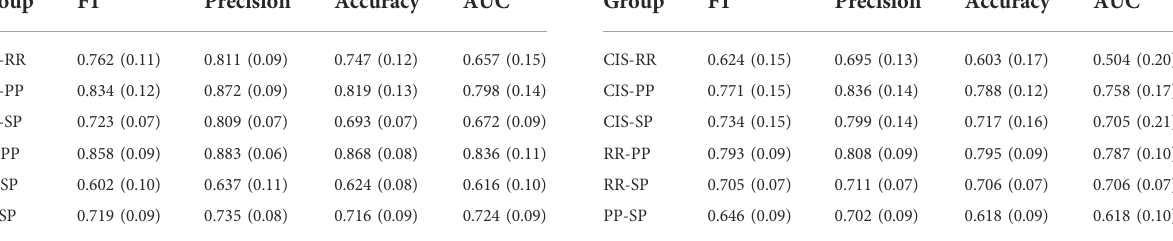
TABLE4Mean(st.dev)ofthepredictiveperformancesoftheensemble model across the ten folds of the cross validation using Glasser 2016 atlas. Group